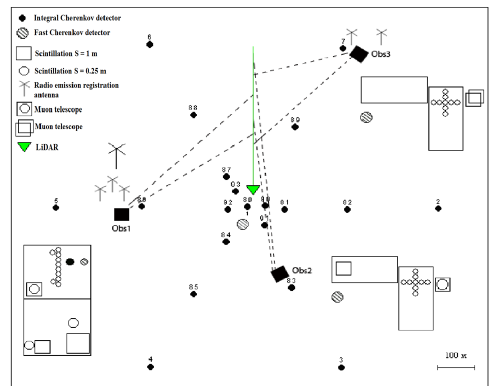
Figure 1. The plan of the Small Cherenkov Array. Placement of the charged particles detectors, muon detectors, and Cherenkov light detectors